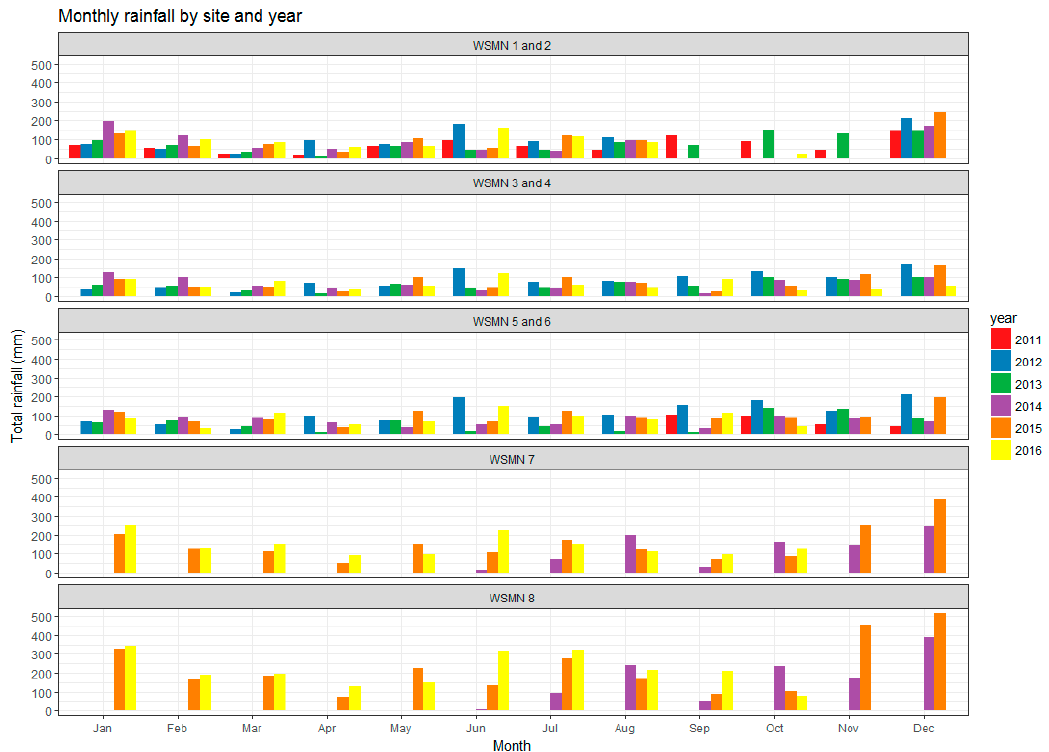
Figure 4. Monthly totals of rainfall measurements from the WSMN sites collected between 2011 and 2016.